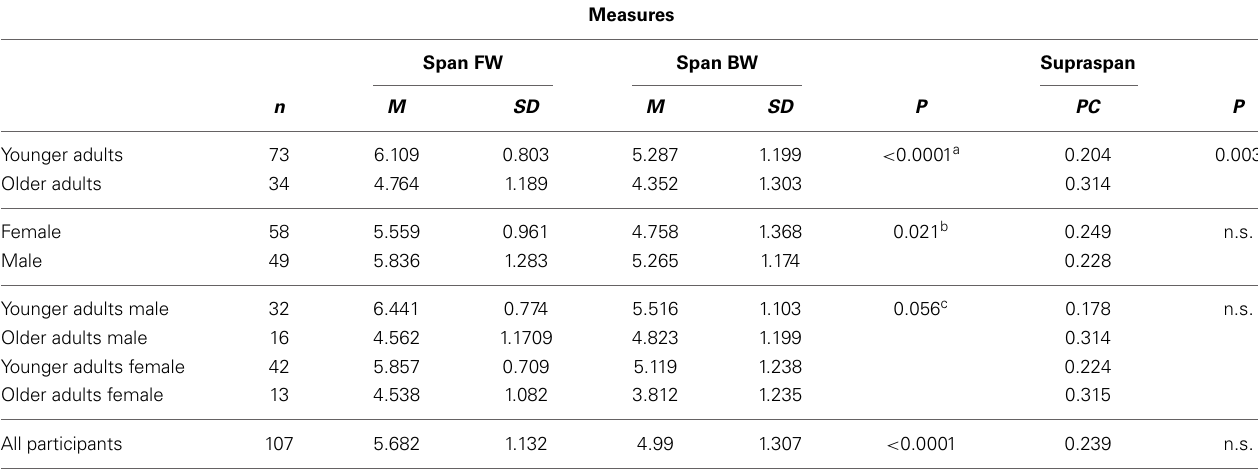
Table 1 | Span and Supraspan scores in all